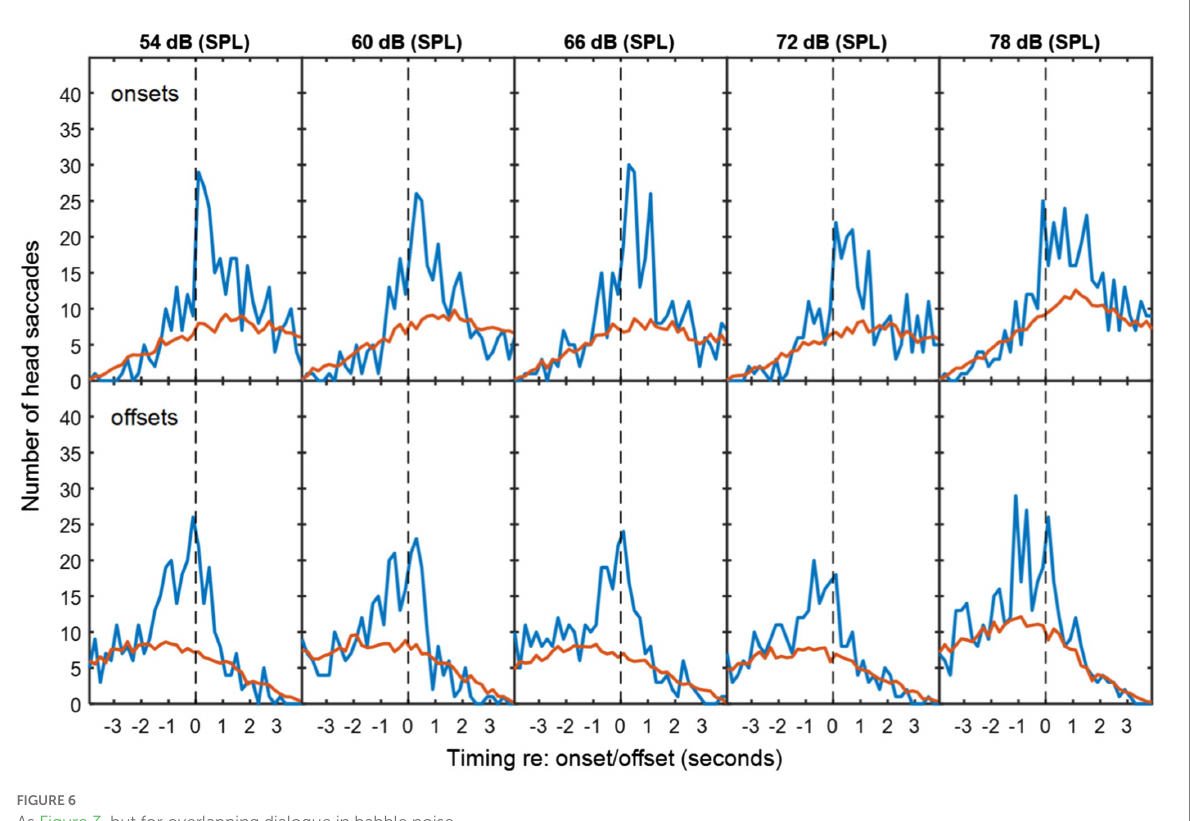
FIGURE 6 As Figure 3, but for overlapping dialogue in babble